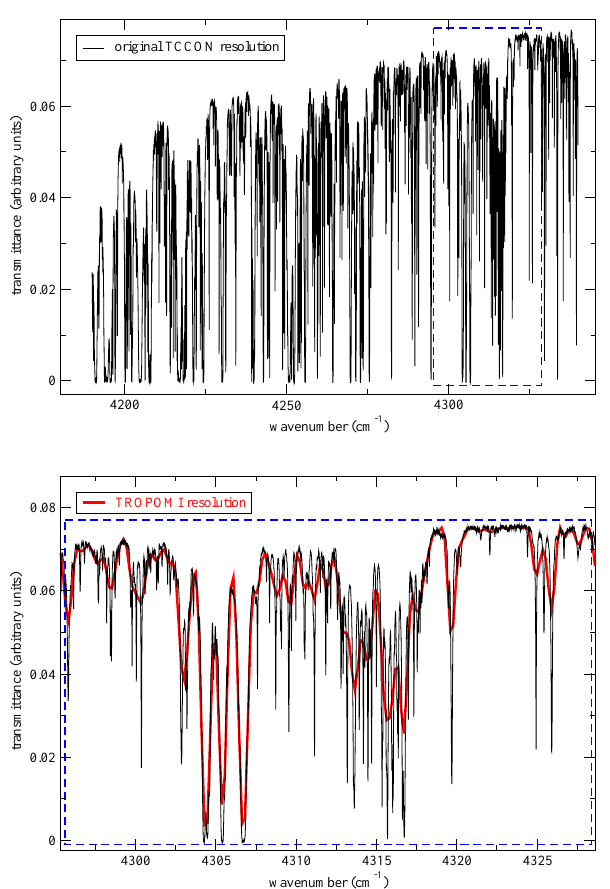
Fig. 1. Upper panel: original TCCON spectrum of the TROPOMI wave number range 4190–4340cm − 1 , measured at Darwin. Lower panel: magnification of the 4300–4325cm − 1 range (blue dashed box) with both the original spectrum (black) and the same spectrum, convolved with the TROPOMI instrument response function (red).